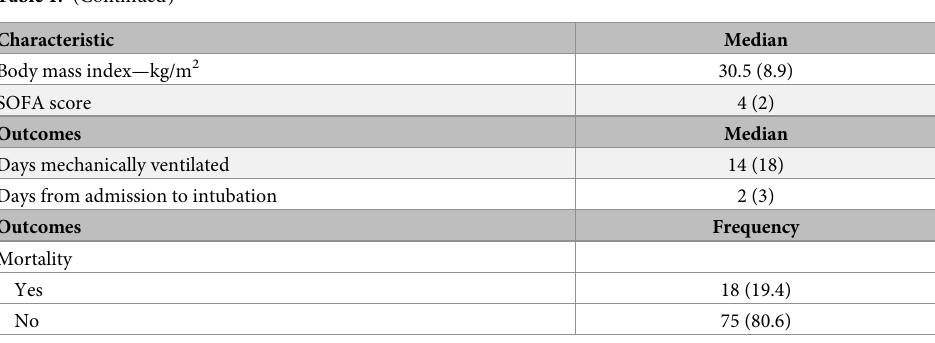
tonin level > 0.1 ng/ml, death occurred at a median duration of 11 days. The results from a fitted multivariable linear regression model with the duration of mechanical ventilation in days as the dependent variable are presented in Table 3. After adjust- ment for age, BMI, chronic cardiac disease, diabetes mellitus, hypertension, and SOFA score on admission, the multivariable linear regression model demonstrated that the duration of mechanical ventilation was on average 5.6 days (95% confidence interval 1.09–10.17, with a lower procalcitonin level. In addition, older age (B = 0.22, 95% confidence interval